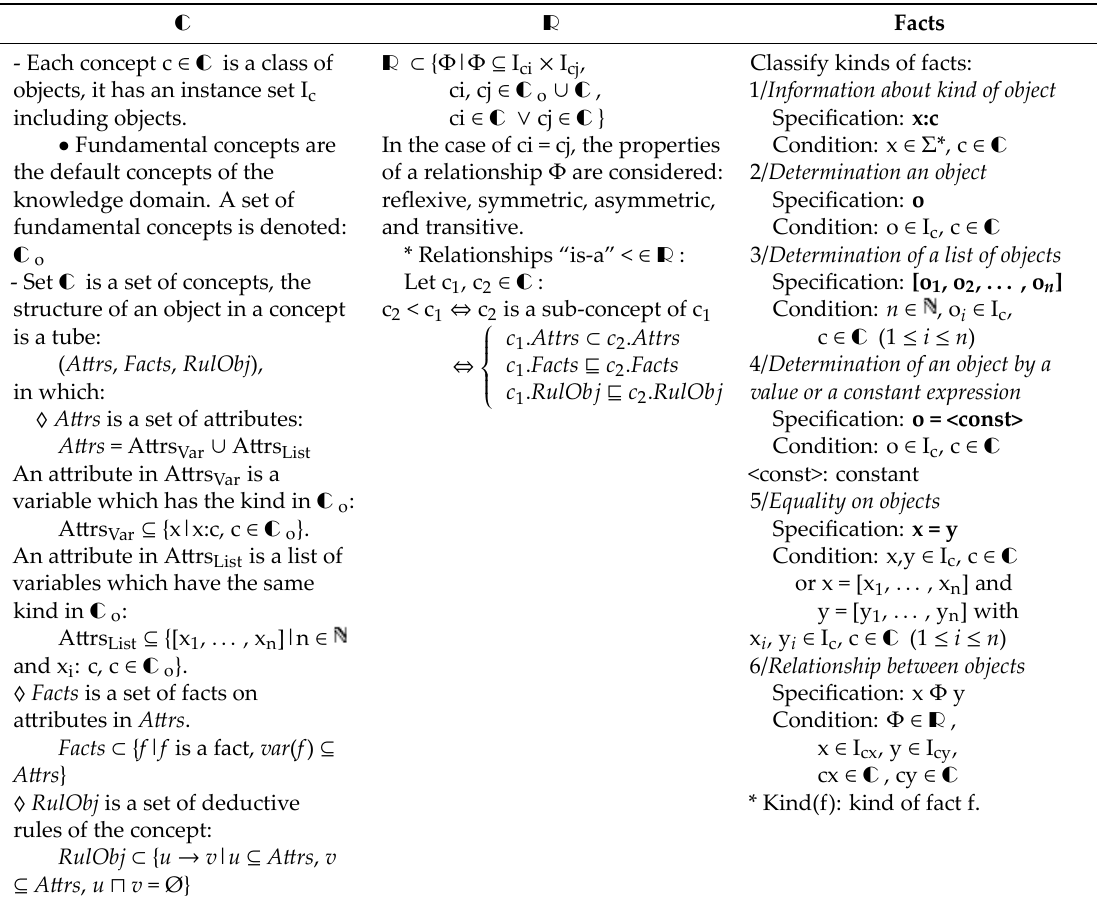
Figure 1. Structure of the knowledge kernel. Table 1. Structure of components in the knowledge kernel.